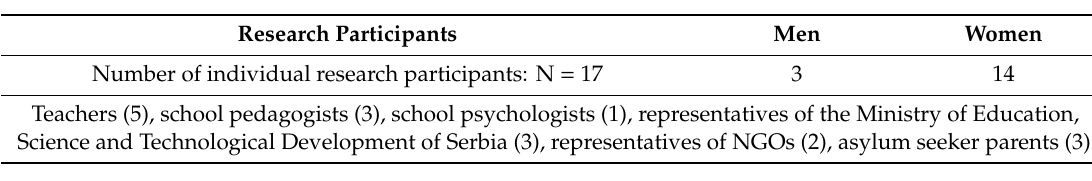
Table 1. “Research